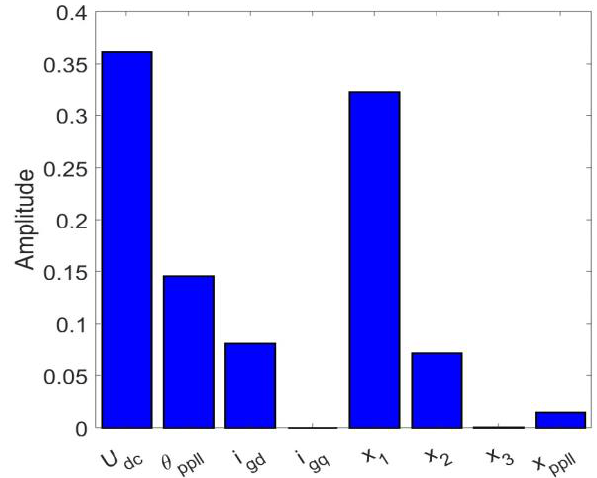
Figure 17. Participation factors of SSR modes with SCR = 1.1.